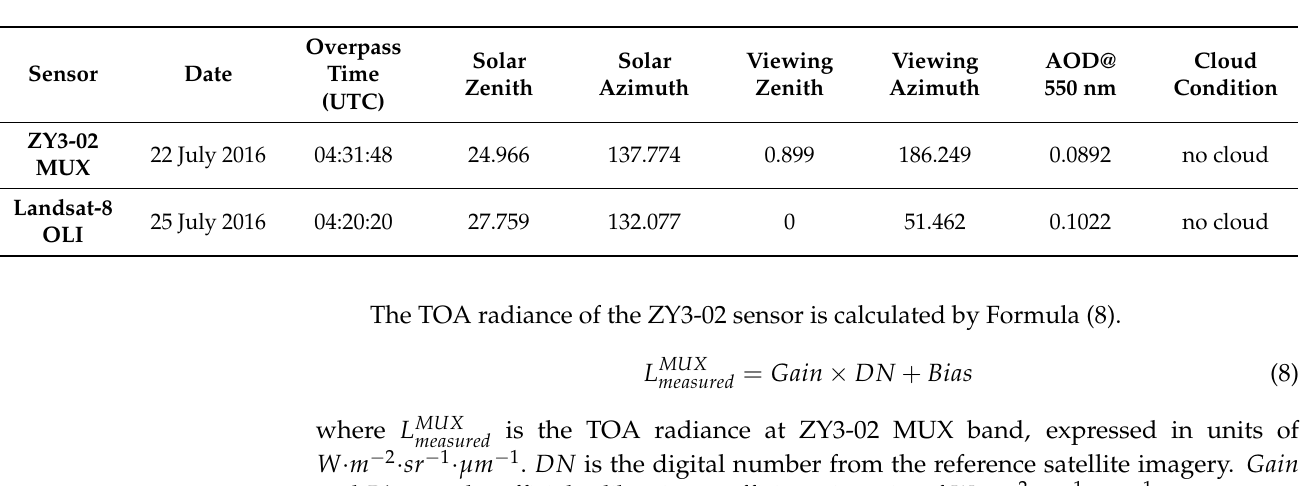
Figure 16. Flow chart of cross-validation with Landsat-8 OLI. Table 8. Geometric conditions of ZY3-02 and Landsat-8 OLI for